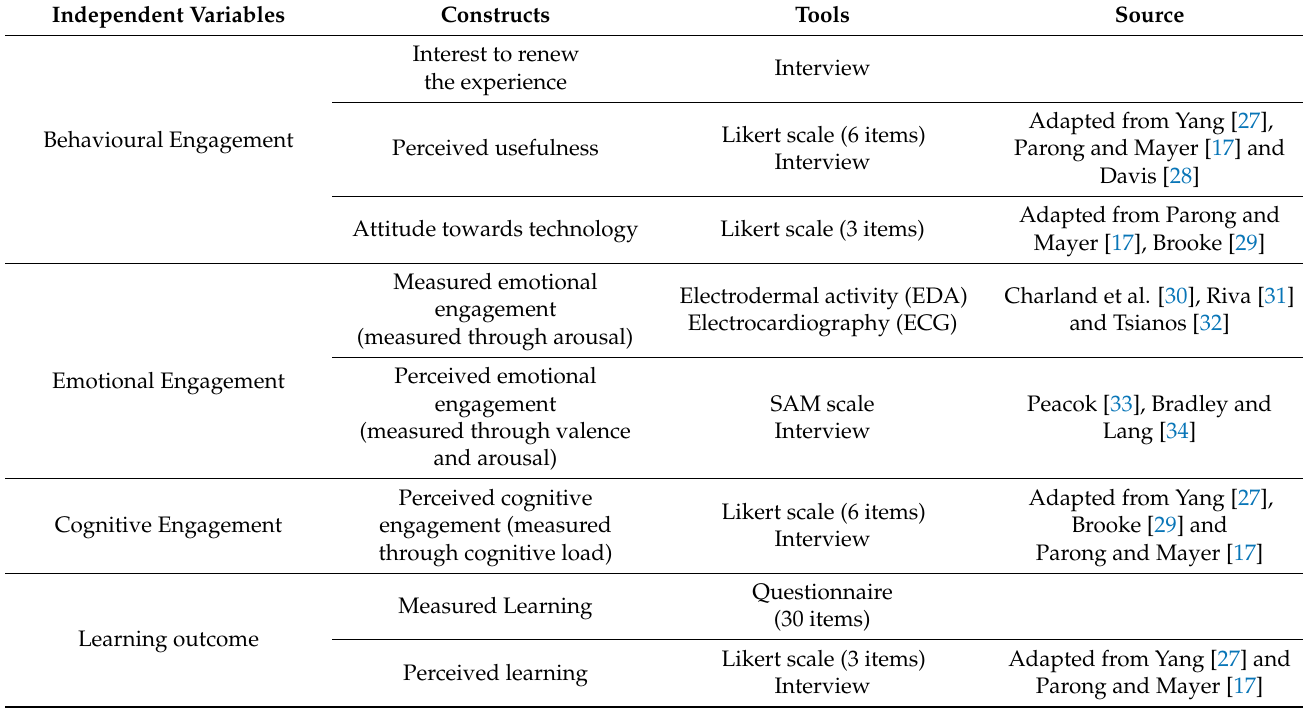
Table 1. Independent variables and their corresponding constructs, measuring tools and their sources. Independent Variables Constructs